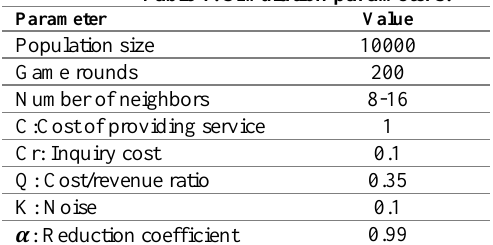
Table 1. Simulation